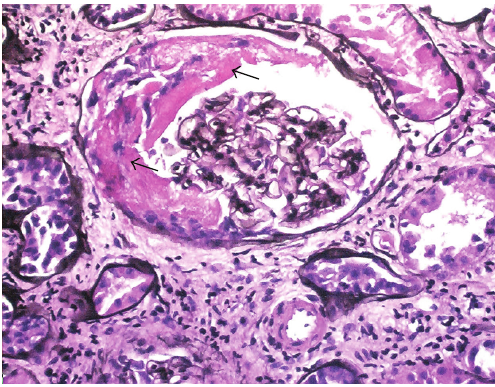
Figure 1: Histopathology slide showing signs of MPA in kid- ney biopsy. Fibrinous crescent filling approximately half of the glomerulus (arrows) with interstitial chronic inflammation. Jones stain/methenamine silver stain, 200x.